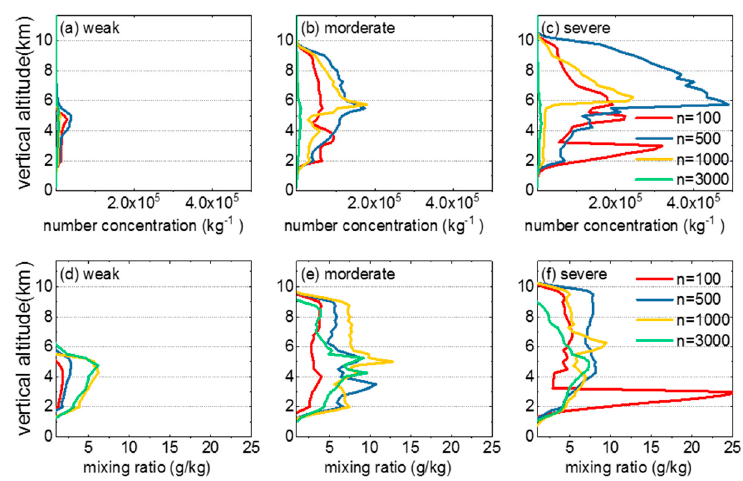
Figure 10. Vertical profiles of the maximum mixing ratio and the maximum number concentration of graupel in ( a ) weak thundercloud, ( b ) moderate thundercloud, ( c ) severe thundercloud; the maximum number concentration of ice crystals in ( d ) weak thundercloud, ( e ) moderate thundercloud, ( f ) severe